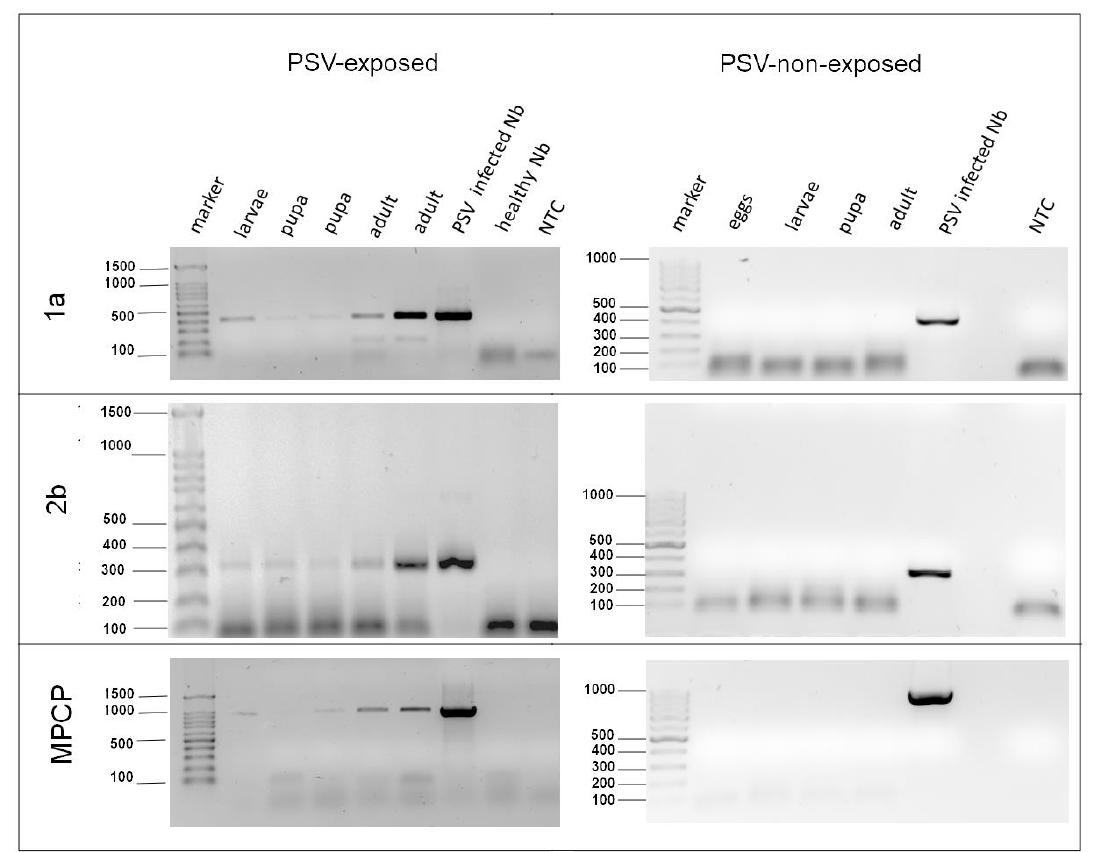
Figure 2. RT-PCR detection of peanut stunt virus RNAs in developmental stages of Bradysia impatiens. The RT-PCR products amplified with three PSV-specific primer pairs hybridizing to 1a, 2b, and fragment spanning 3a gene (movement protein, MP) and coat protein (CP); total RNA isolated from larvae, pupae, and adults (2 – 3 specimens) of B. impatiens population cultivated in laboratory conditions on Petri dishes were used as a template. M — marker Gene Ruler 100 bp (Thermo Scientific, Lenexa, KS, USA); NTC — no template control.